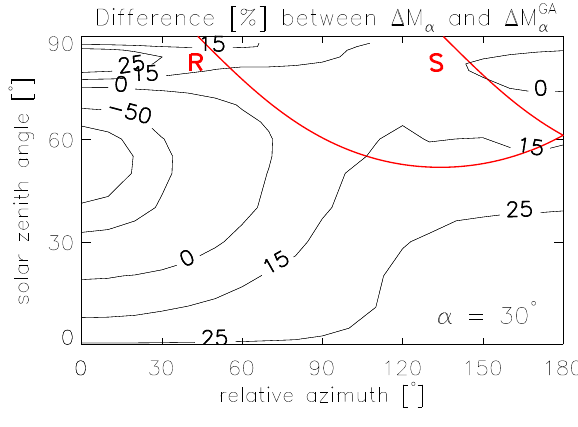
Fig. 12. Difference between the differential air mass factor simulated with the DAK radiative transfer model, and the differential air mass factor of the geometrical approximation (GA) for 30 ◦ elevation, as a function of solar position. AOT = 0.2, λ = 428.22 nm . As an example, the red curve represents the path of the sun trough the sky above De Bilt on 21 March 2009, relative to the viewing azimuth of the instrument, which was 46 ◦ East from North (sunrise is indicated by “R”, sunset by “S”).